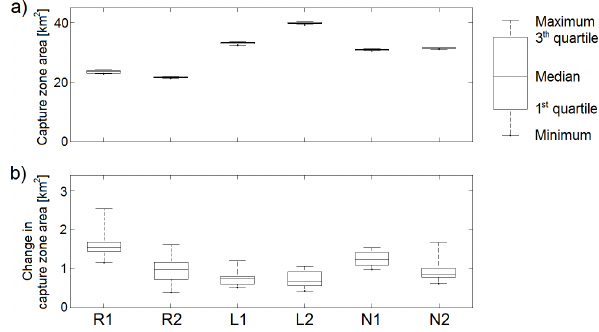
Figure 8. (a) Box plot of the simulated capture zone area for Lavringe well fields and (b) box plot of the percentage change in capture zone area from reference to future